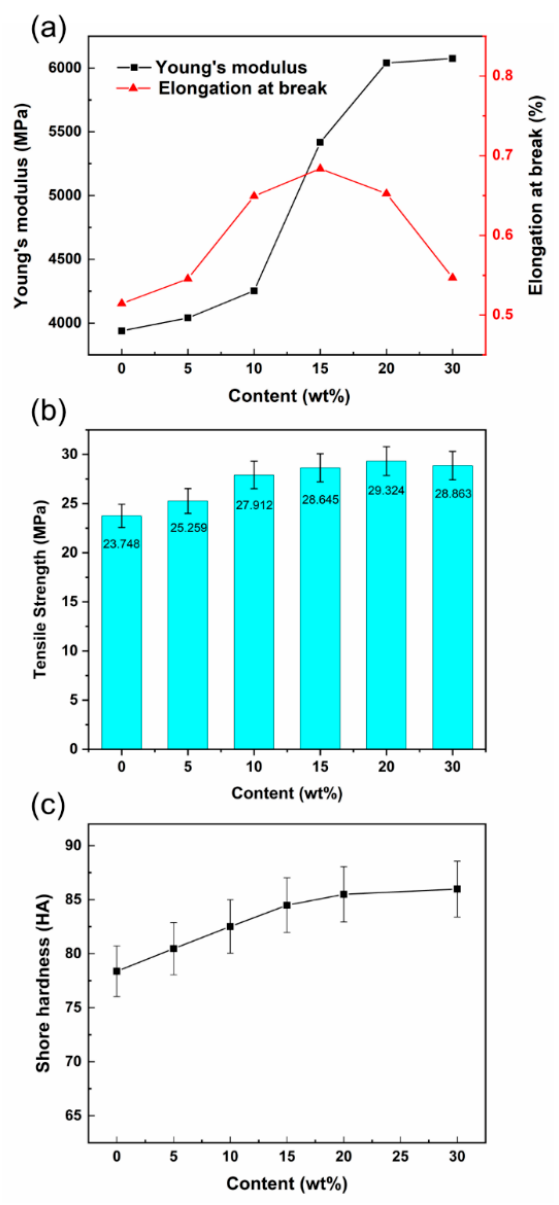
Figure 9. Mechanical properties of Sm 2 O 3 -APTES/AFG-90H: ( a ) Young’s modulus and elongation at break; ( b ) tensile strength; ( c ) Shore hardness.